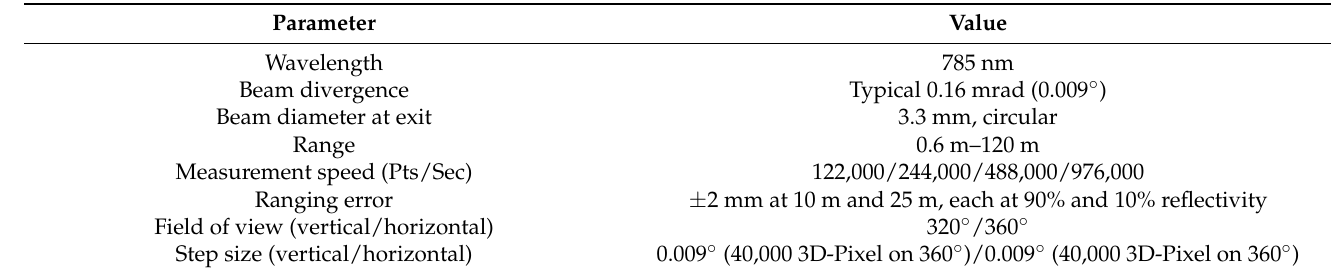
Table 2. Technical data of the FARO Photon